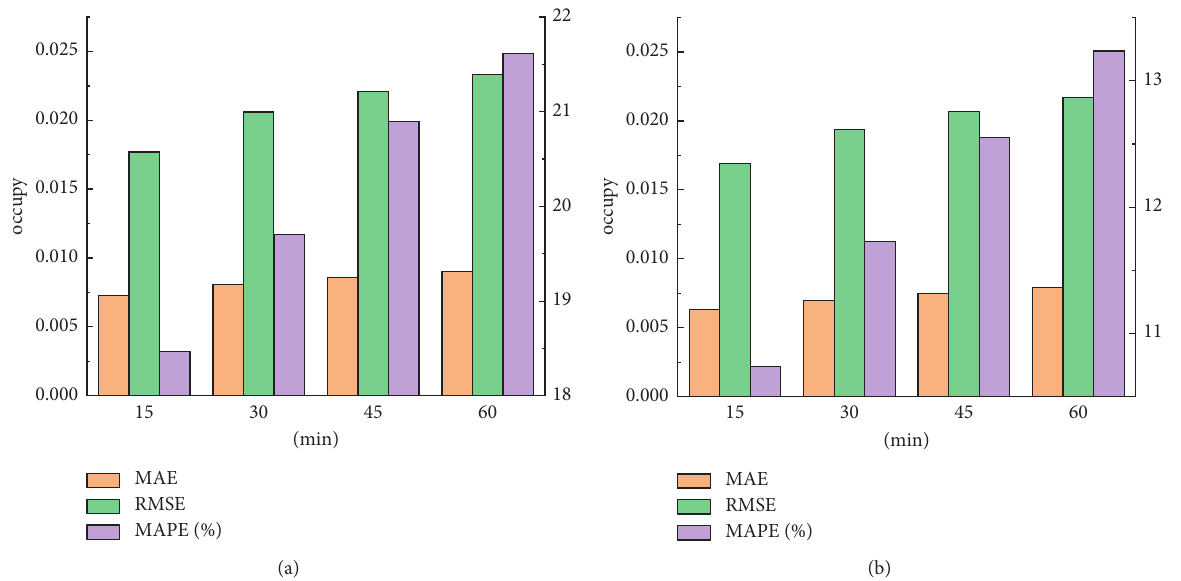
Figure 17: Performance comparison of occupy on PEMSD4 and PEMSD8 datasets. (a) Performance comparison of occupy on PEMSD4. (b) Performance comparison of occupy on PEMSD8.